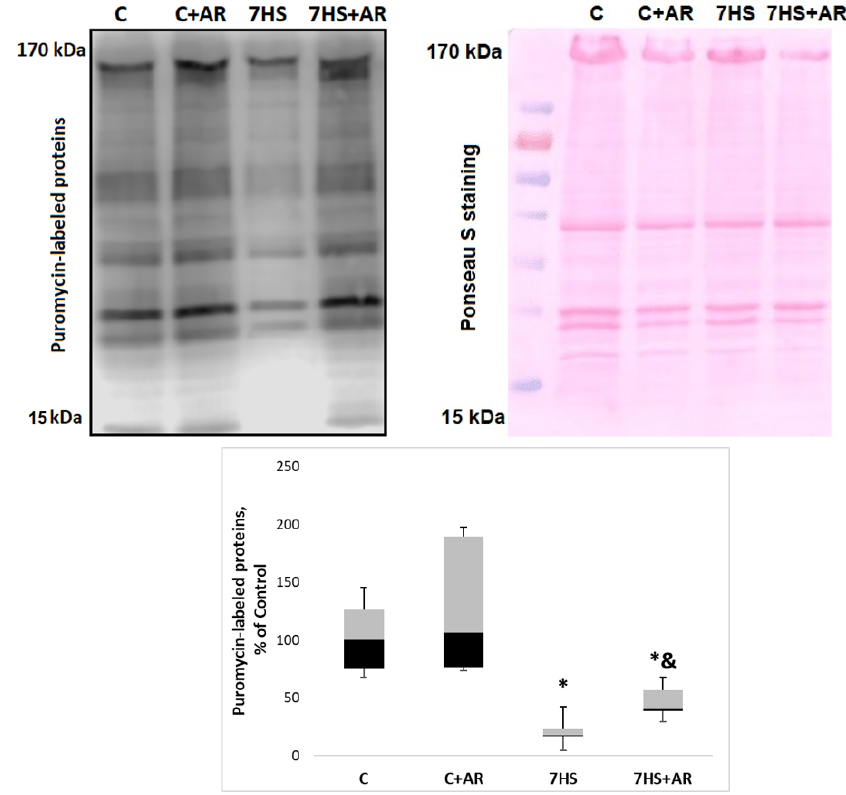
Figure 7. Effect of GSK-3 inhibition during 7-day unloading on the rate of protein synthesis in rat soleus muscle. Data are presented as median, interquartile range, minimum and maximum values, expressed as % of control. C, vivarium control group, C + AR, vivarium control rats + daily injections of GSK-3 inhibitor (AR-A014418) for 7 days, 7HS, hindlimb suspension for 7 days, 7HS + AR, 7-day hindlimb suspension + daily injections of GSK-3 inhibitor (AR-A014418), *: p < 0.05 vs. C, $: p < 0.05 vs. 7HS.